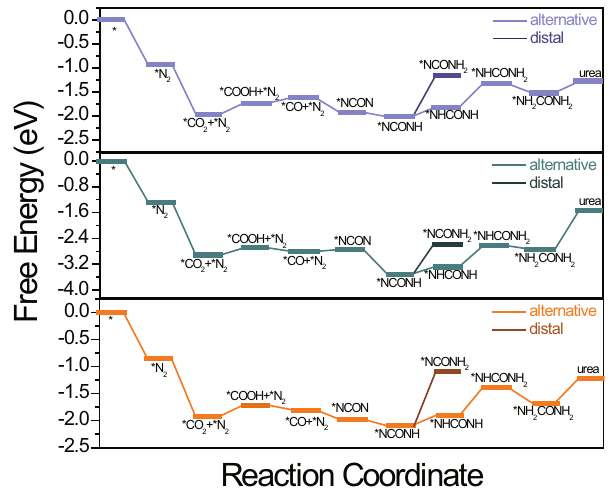
Fig. 3 Catalytic activity of MBenes. Free energy pro fi les of electrochemical urea production on Mo 2 B 2 , Ti 2 B 2 , and Cr 2 B 2